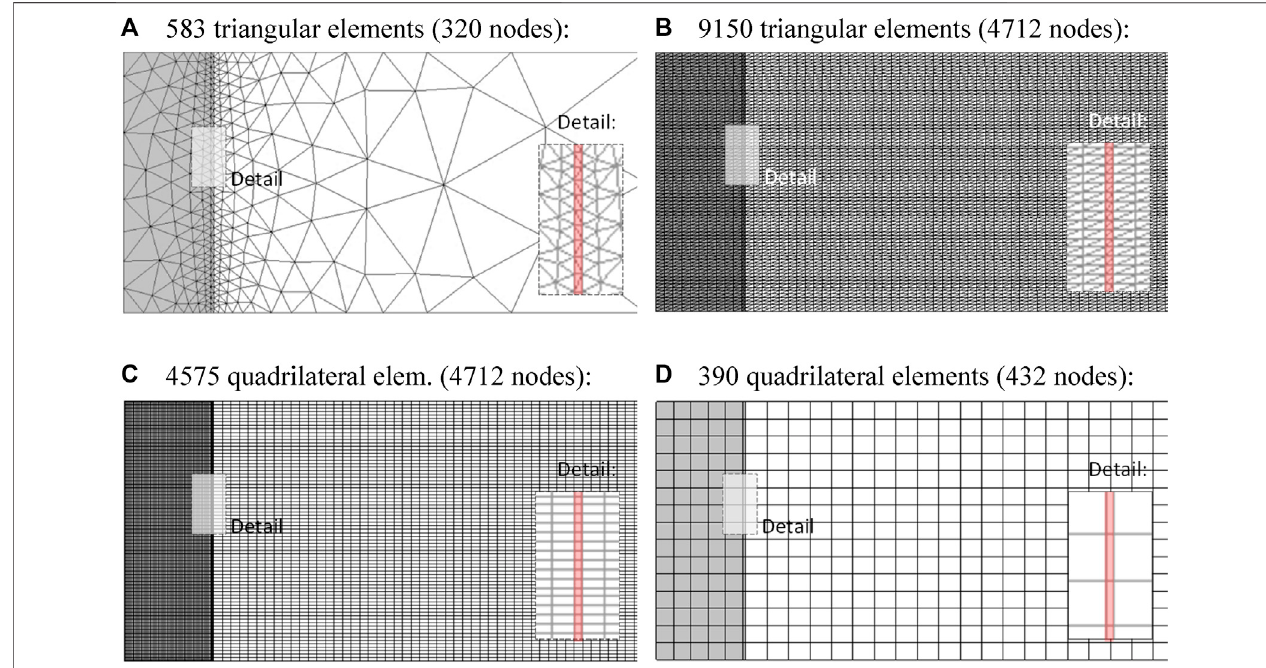
FIGURE 7 | Four different fi nite element meshes for the same soil – structure interaction example using CODE_BRIGHT, with the same interface virtual thickness of ti = 18 mm: (A) unstructured mesh with linear – triangular elements, (B) linear – triangular structured-mesh, (C) bilinear – quadrilateral structured- fi ne-mesh, and (D) and bilinear – quadrilateral structured-coarse